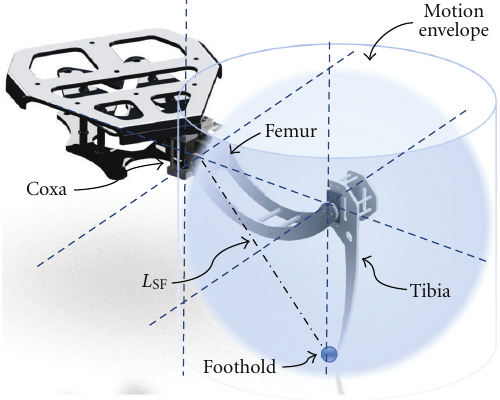
Figure 2: Structure of an individual leg.